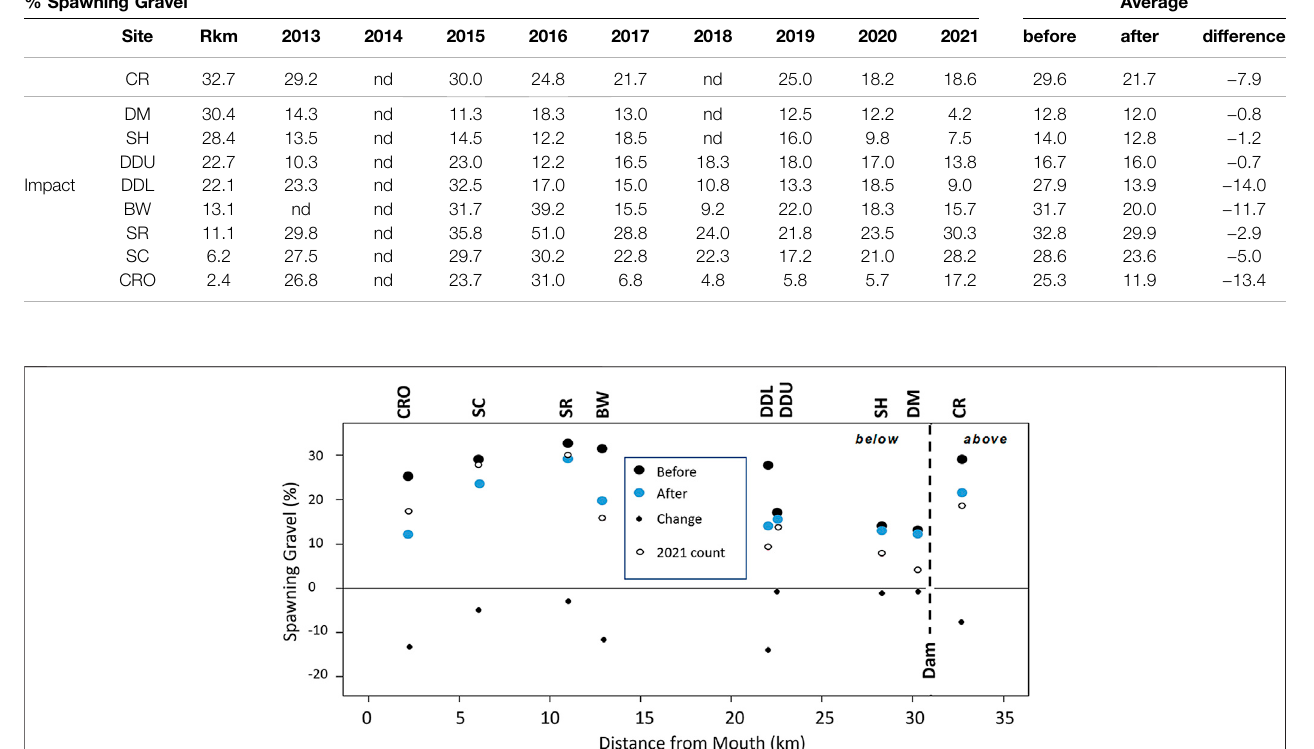
TABLE1| Timeseriesofpercentofgravelbetween32and90 mminthebedoftheCarmelRiveratthestudysites.SiteCRisupstreamoftheformer SanClementeDam.All other sites are below the dam site. Site locations in Figure 1 . No data were collected in 2014. % Spawning Gravel